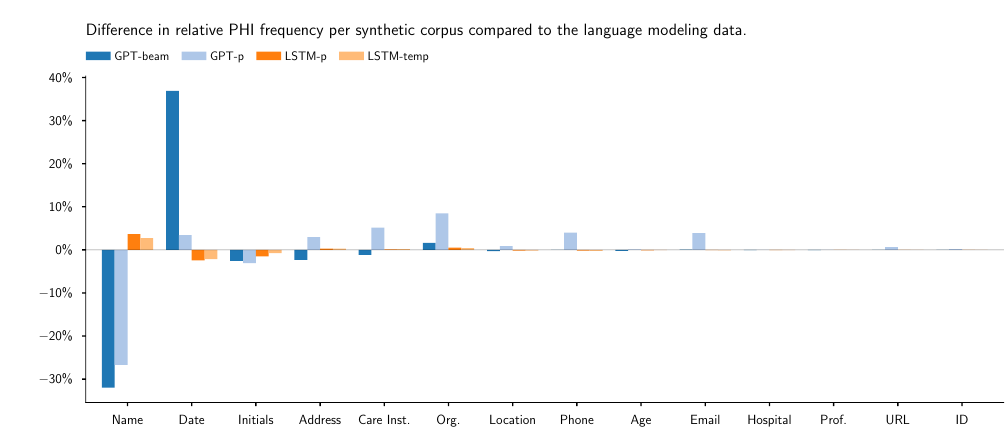
Figure 5. How well do the synthetic corpora reflect the real PHI distribution? This figure shows the differences to the PHI distribution of the language model training data (cf. Table 1).